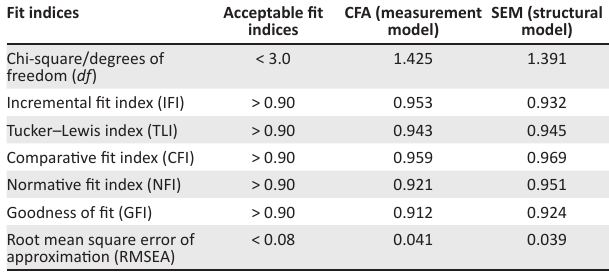
TABLE 4: Model fit